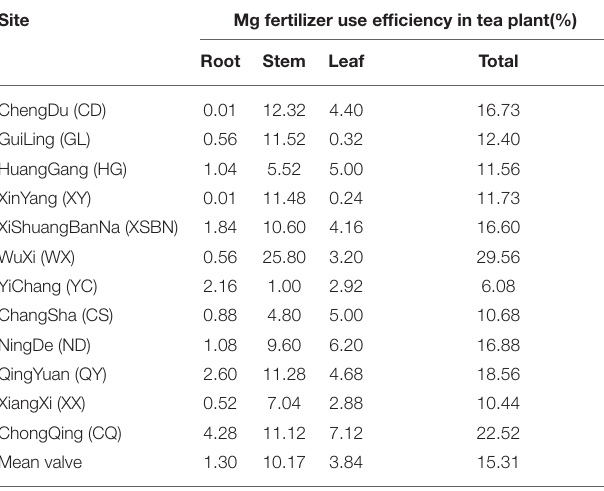
TABLE 3 | Magnesium fertilizer use efficiency in typical tea plantation